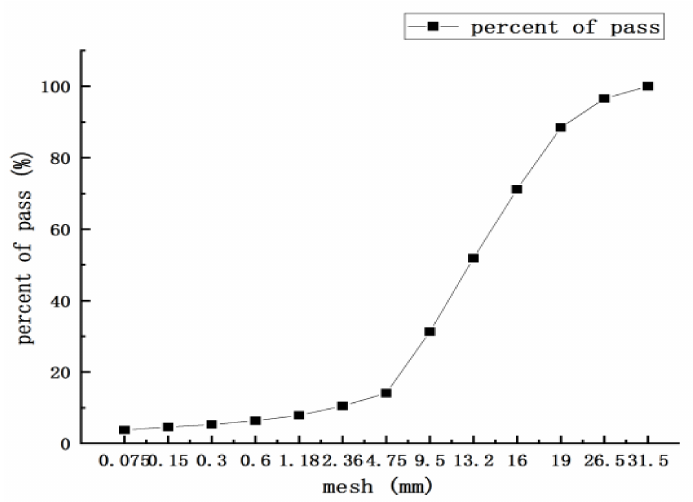
Figure 2. Passing rate of OLSPM-25 aggregate with 20%